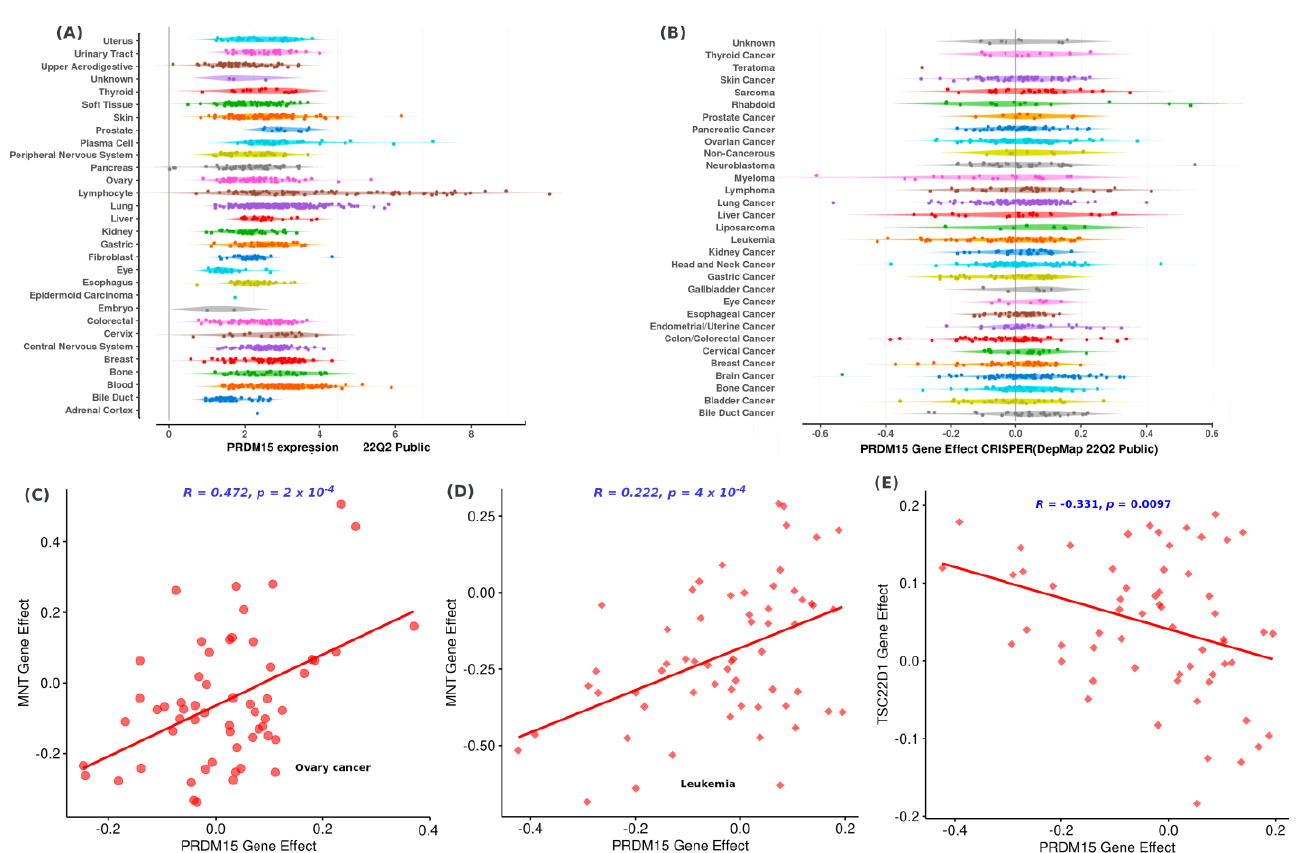
Figure 2. Examination of the cancer cell dependency on PRDM15 gene knockout from the DepMap data. ( A ) PRDM15 is overexpressed (x-axis indicates the expression log2 value) in all cell lines, particularly lymphocyte cell lines. ( B ) PRDM15 knockout decreases the proliferation of cancer cells. ( C ) Ovary cancer shows co-dependence on PRDM15 knockout and knockout of MNT. ( D ) Leukemia cancer displays co-dependence on PRDM15 knockout and MNT knockout, and ( E ) TSC22D1 gene.